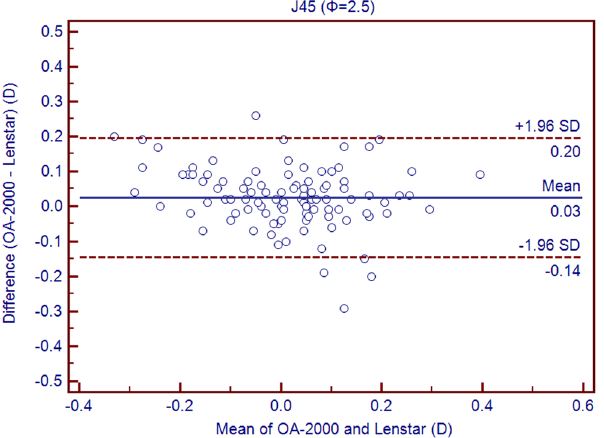
Figure 11. Bland-Altman plots show the agreement between OA-2000 swept-source optical coherence tomography and Lenstar optical low coherence reflectometry for measuring vectors J 45 at 2.5 mm. Solid lines represent the bias between both devices and dotted lines represent the 95% confidence interval for the difference.